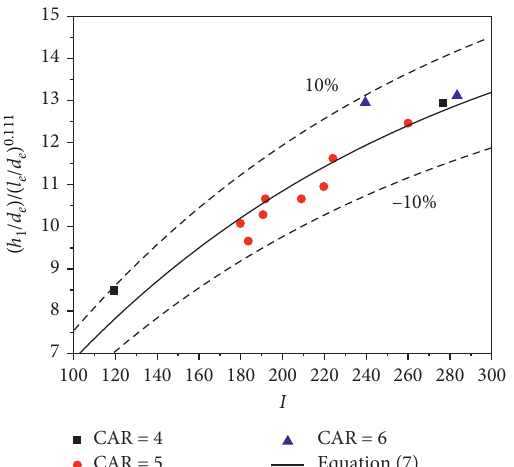
Figure 13: Relationship between equation (7) and experimental results.